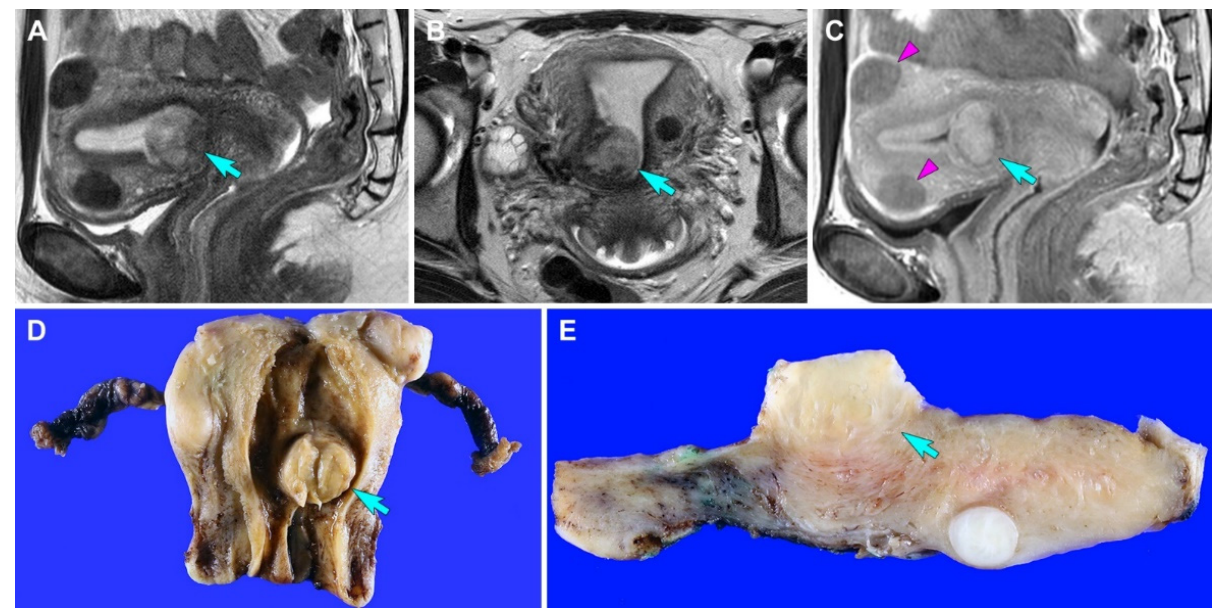
Figure 1. Imaging and gross findings (case 1). ( A , B ) T2-weighted ( A ) sagittal and ( B ) axial magnetic resonance imaging (MRI) reveals a relatively well-circumscribed mass in the uterus (blue arrows). ( C ) Contrast-enhanced T1-weighted turbo spin-echo sagittal MRI reveals that the tumor appears to involve the superficial myometrium. The signal intensity of the uterine mass (blue arrow) is higher than that of intramural leiomyomas (purple arrowheads). ( D ) Grossly, a well-circumscribed mass (blue arrow) is located in the uterine corpus. ( E ) The cut section shows an exophytic mass (blue arrow) that appears to invade the superficial